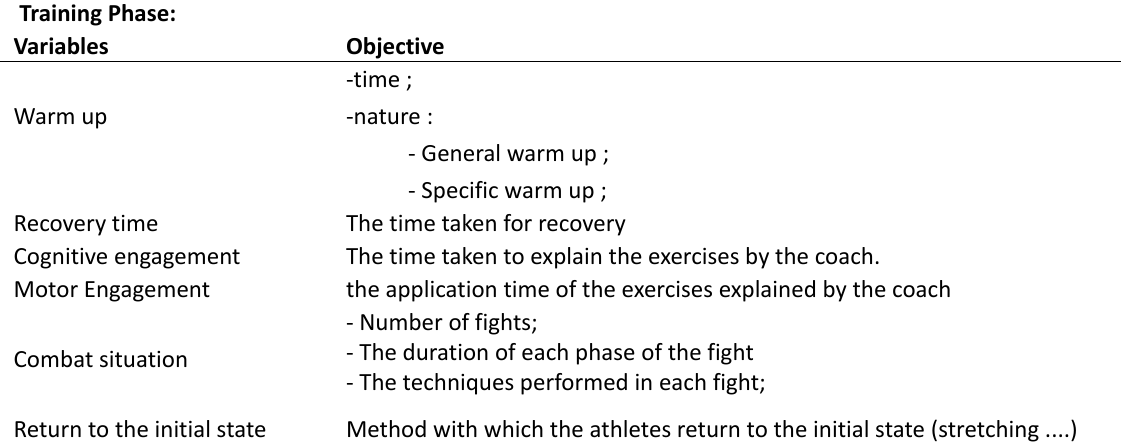
Table 2. The different variables studied in the competition phase Competition Phase